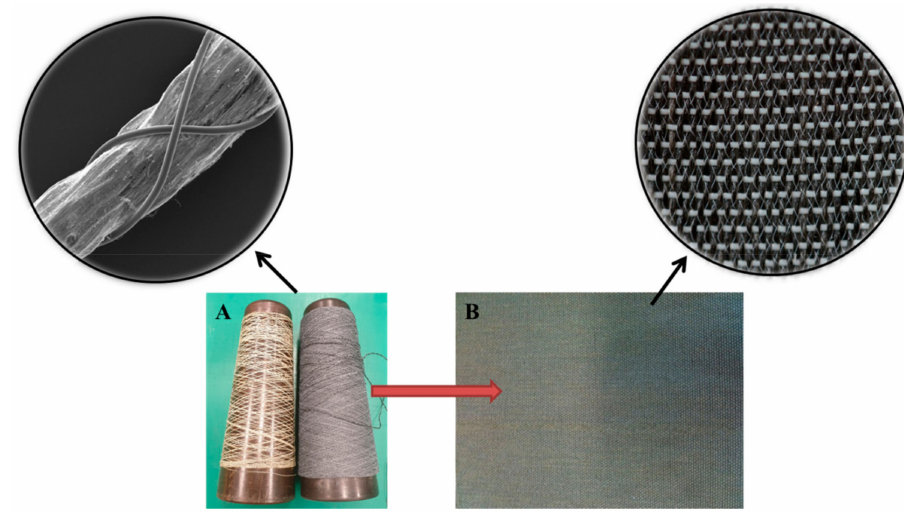
Figure 3. Fabrication of nanofiber-covered yarn: ( A ) nanofiber / NP-covered yarn, ( B ) woven fabric.